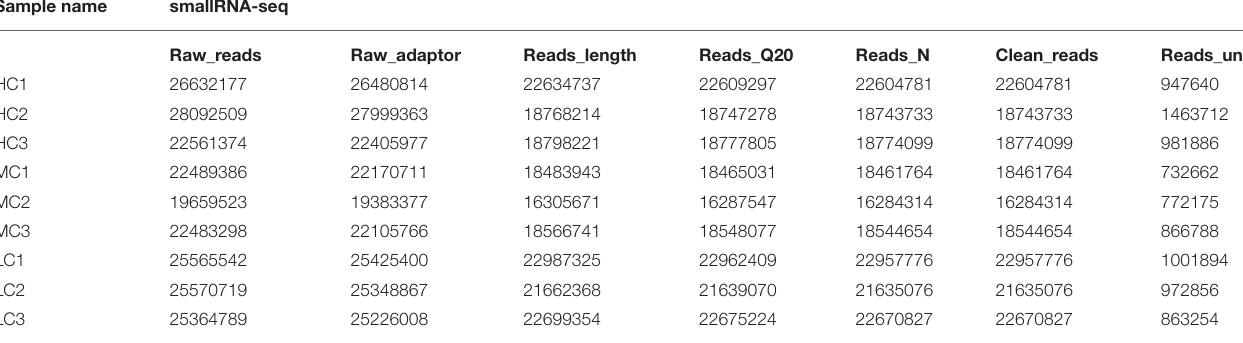
TABLE 2 | The statistics summary for the smallRNA-seq data of the nine